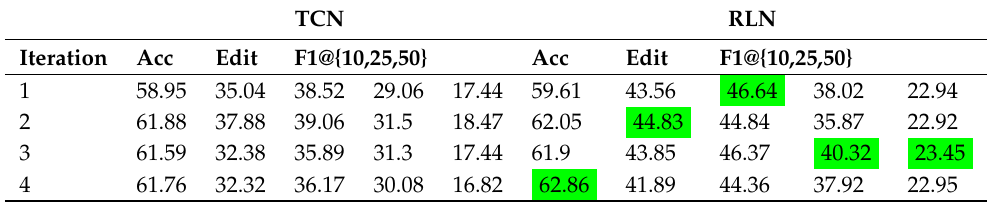
Table 12. RL-SSI in the Salad context.